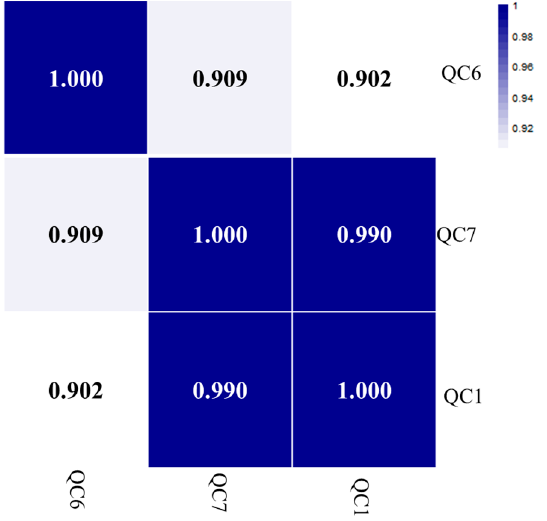
Figure 2. Correlation analysis of QC samples. QC samples were a mixture of all tested samples, used to evaluate instrument stability. The correlation was entirely above 0.9, indicating that the data were valid.